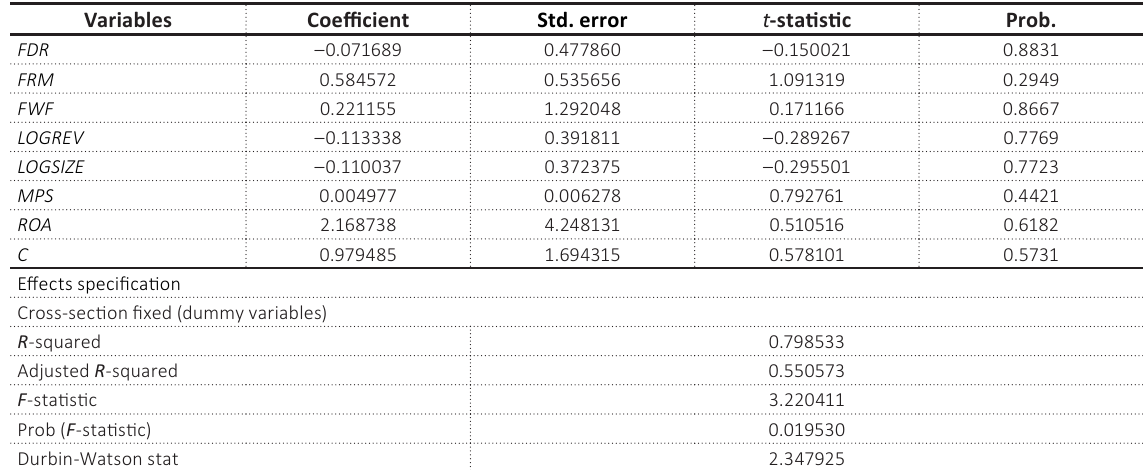
Table 5. Fixed effect panel